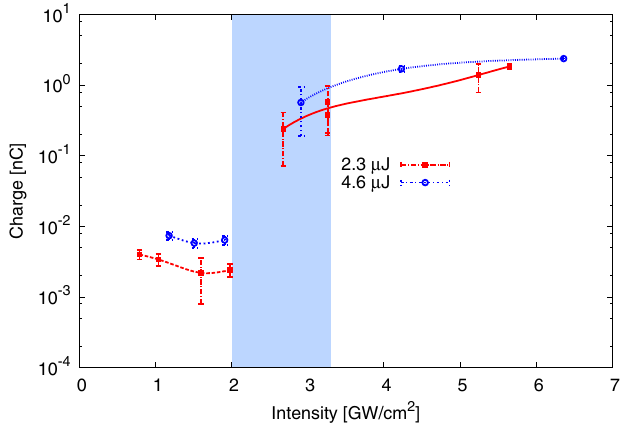
FIG. 5. Charge versus laser intensity for an etched, nonreacted wire at two different laser energies. For each energy, the laser intensity is modified by changing the laser spot size and keeping the laser power constant. The blue region marks an unstable operation of the gun between the low and the high charge regime as shown by the much larger error bars. The lines are a guide to the eye.